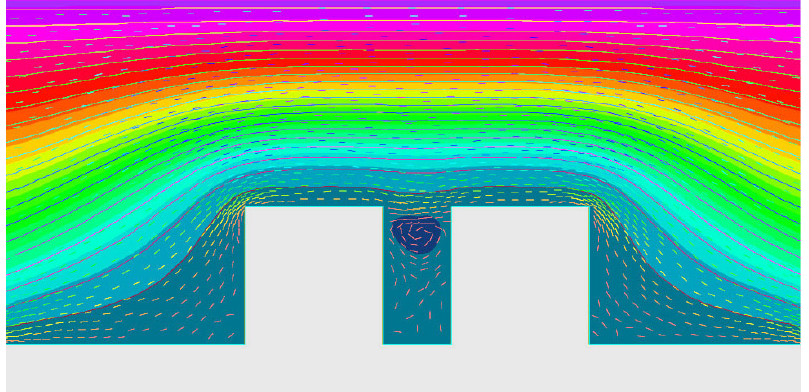
Figure 5. Streamlines for D >